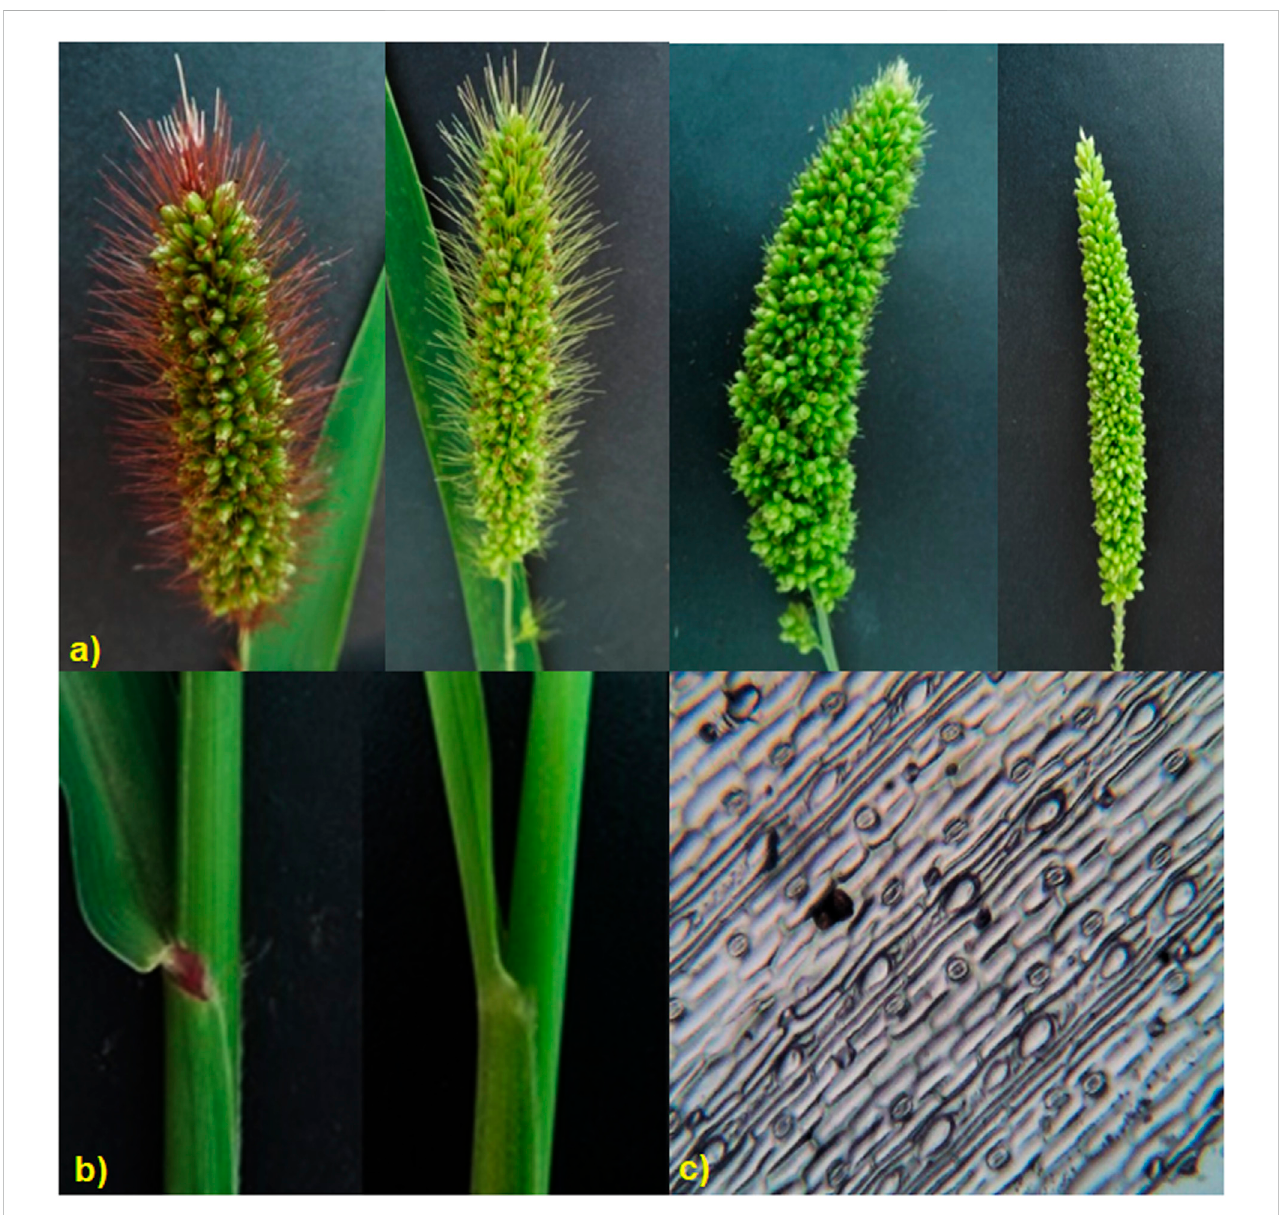
FIGURE 2 Morphological, yield and yield related traits measured in twenty foxtail millet landraces along with four released cultivars (A) panicle variation, (B) leaf sheath color variation, (C) Stomatal and epidermal cell variation.